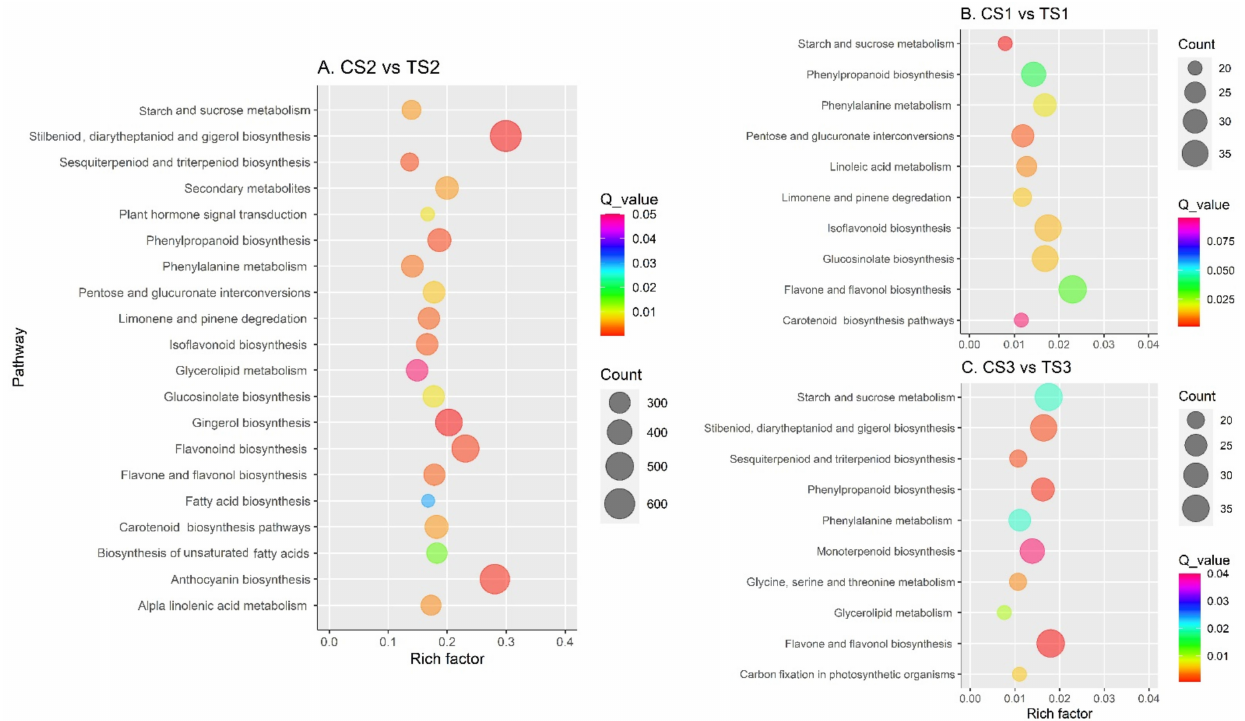
Figure 6. The scatter plots of the significant KEGG enrichment of functional pathway analysis of DEGs. ( A ) Top 20 pathway enrichment results for the DEGs of Hydrangea macrophylla at the CS2 vs. TS2 developmental stages. The x-axis indicates the log (corrected p -value). The greater the x-value, the smaller the corrected p -value, suggesting the enrichment is more significant. The y-axis represents the function descriptions of the enriched pathways. The anthocyanin biosynthesis pathway is the most significant enriched pathway. ( B ) Top 10 pathway enrichment results for the DEGs of Hydrangea macrophylla at the CS1 vs. TS1 developmental stages. The flavone and flavonol biosynthesis pathways are the most significant enriched pathways. ( C ) Top 10 pathway enrichment results for the DEGs of Hydrangea macrophylla at the CS3 vs. TS3 developmental stages. The flavone and flavonol biosynthesis pathways are the most significant enriched pathways, followed by starch and sucrose